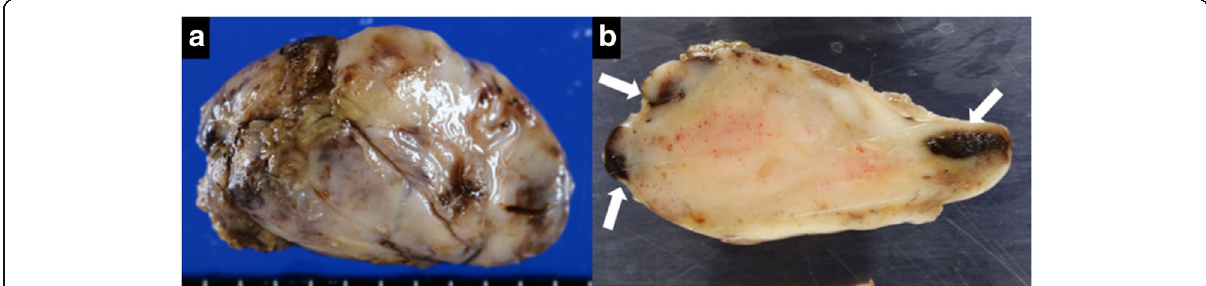
Fig. 5 a Gross examination of the tumor. b Sectioned gross specimen demonstrates a solid, yellowish-white cut surface with hemorrhagic (white arrows)